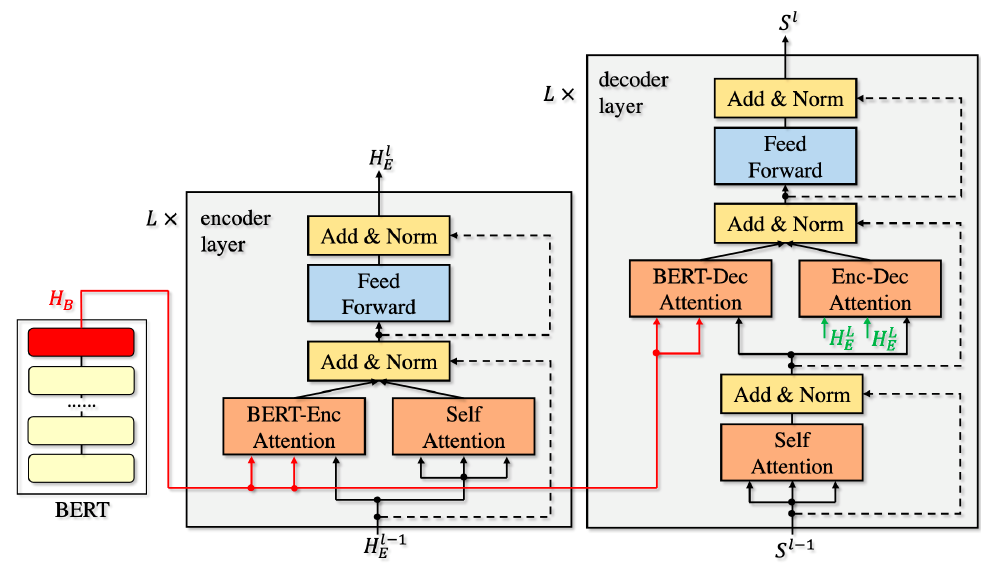
Figure 4. The BERT-fused model is a seq-seq model based on the transformer, and like the transformer, it has an encoder and a decoder. This is the model we use in the experiments of this